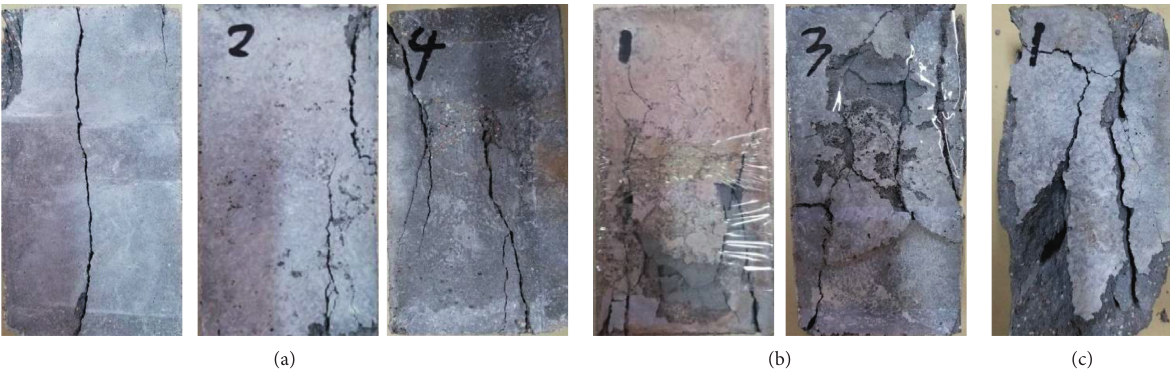
Figure 15: Crack morphology of specimens at different relative higher temperatures. (a) t � 100 ° C. (b) t � 200 ° C. (c) t � 300 °